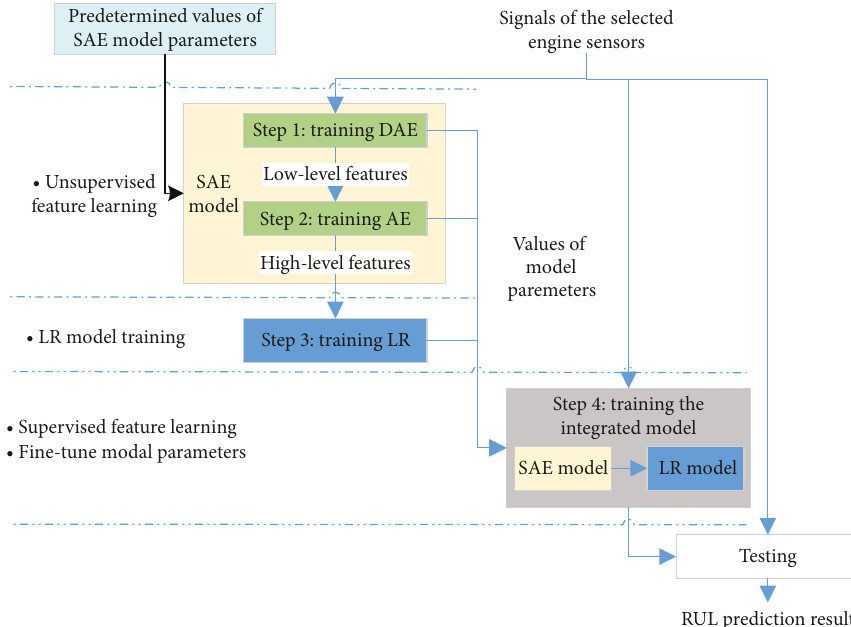
Figure 5: Procedure for training the SAE-based RUL prediction model.